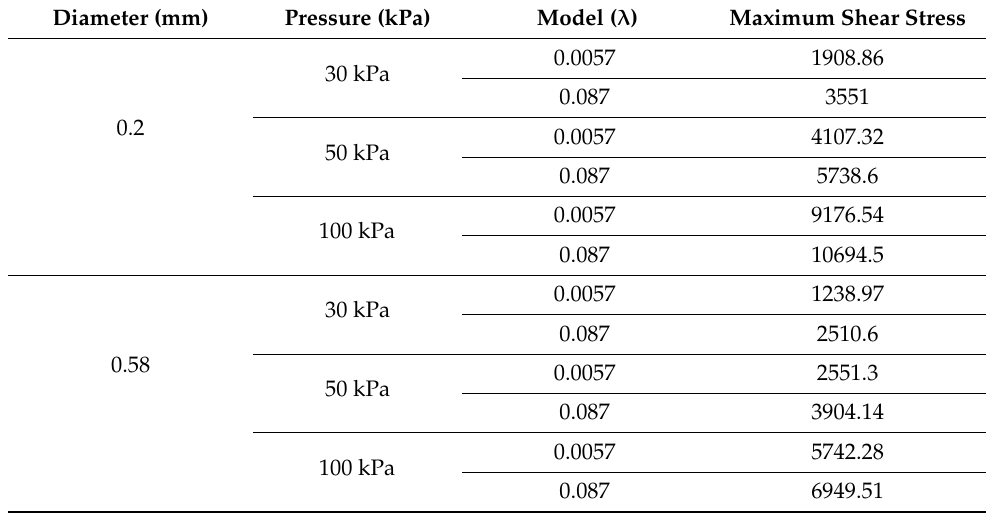
Table 2. Alginate model: summary of results.